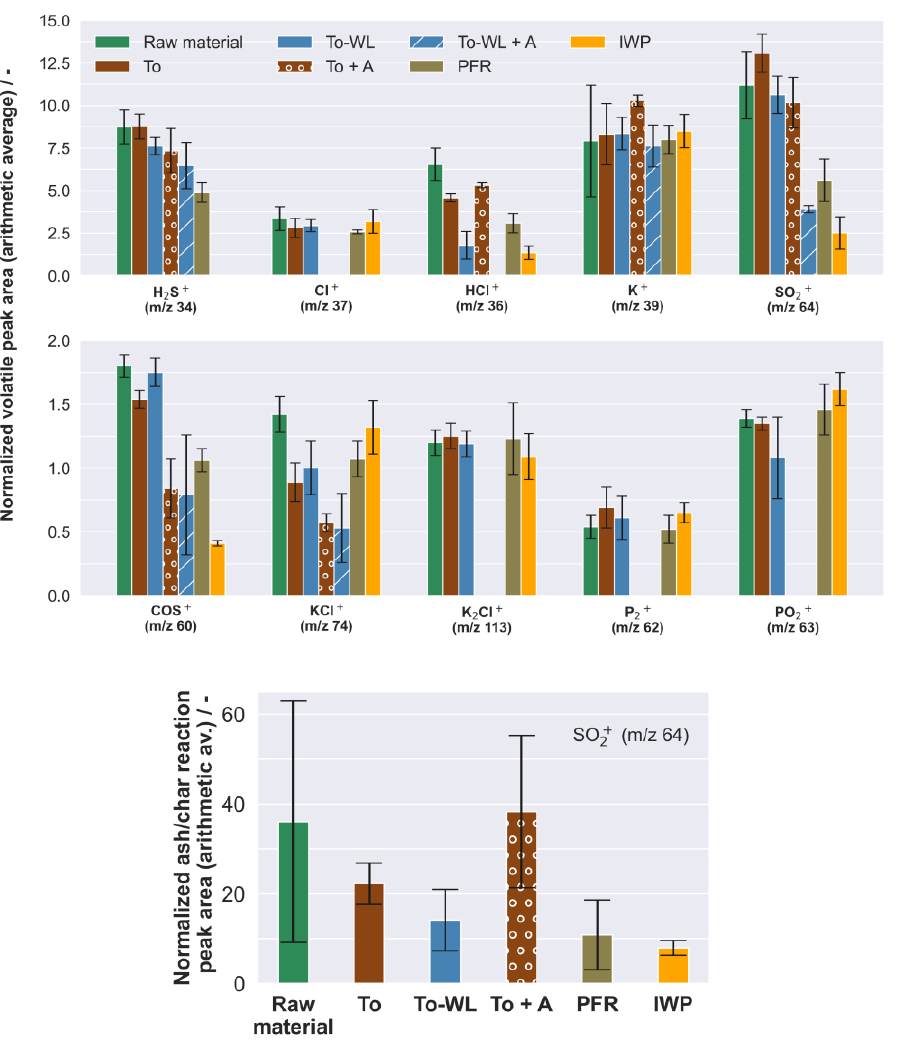
Figure 6. Averaged, normalized peak areas of species released during pyrolysis/devolatilization phase ( top ) and char gasification or ash reactions ( bottom ). For To-WL + A, no char gasification/ash reaction was observed.